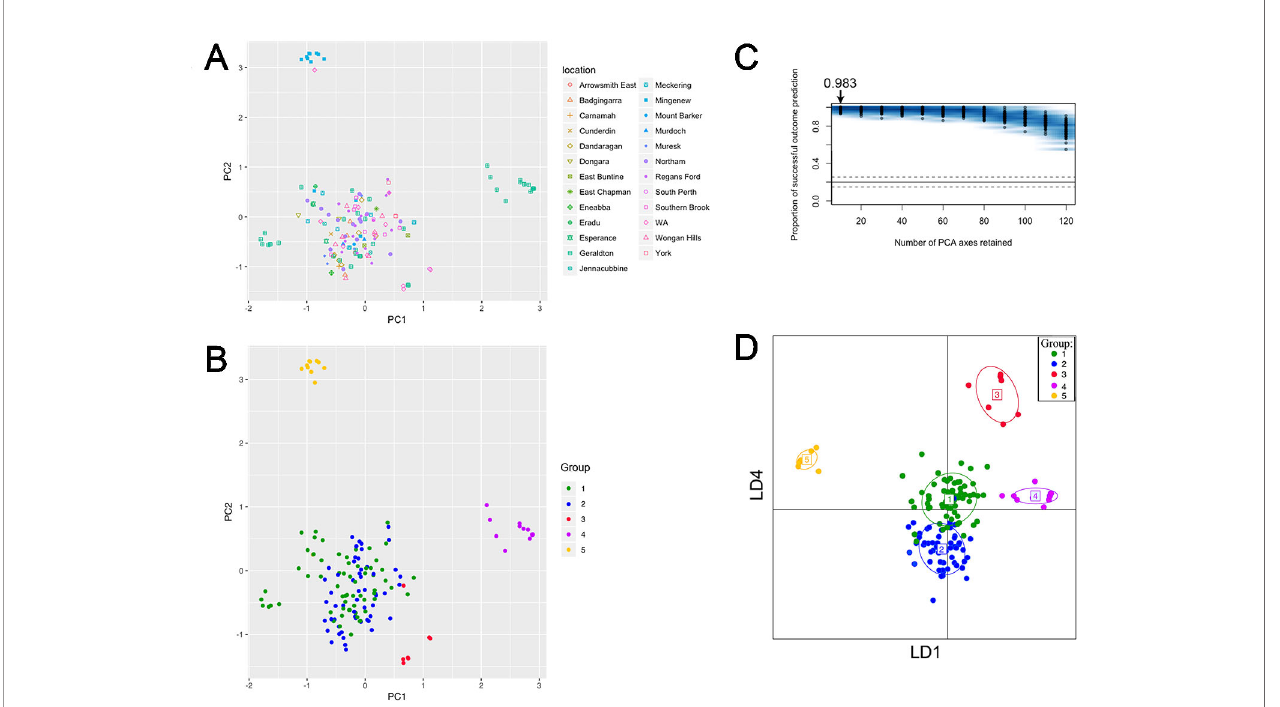
FIGURE 3 | PC and DAPC analyses of population structure among 153 clone-corrected Australian P. nodorum isolates. First two PCs are shown where each point represents an isolate. (A) Sampling locations are indicated. (B) Isolates presented by genetic groups based on unbiased maximum-likelihood genetic clustering. (C) DAPC cross-validation test was performed for 10 to 120 PCs. Optimal number PCs to achieve the highest proportion of correct prediction outcome for the fi ve- group model is shown. (D) PC1 to PC10 were DAPC-transformed to generate a simulated scatterplot displayed as LD1 and LD4 functions.